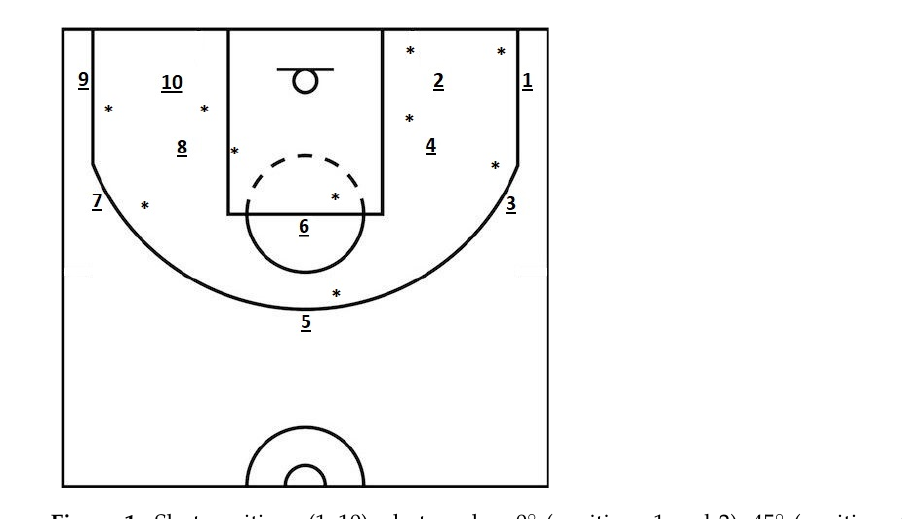
Figure 1. Shot positions (1–10); shot angles: 0° (positions 1 and 2), 45° (positions 3 and 4), 90° (positions 5 and 6), 135° (positions 7 and 8) and 180° (positions 9 and 10). * Location of the passer.